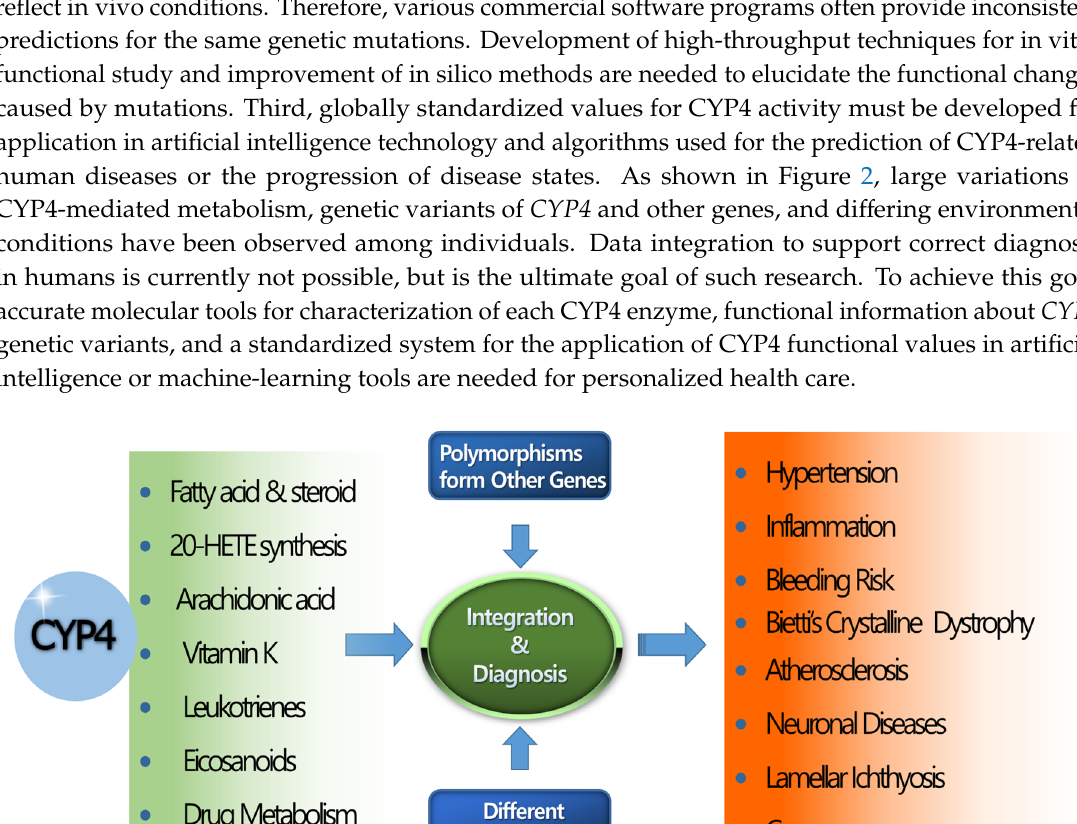
Disease? Pharmaceutics 2017, 9 , 44.